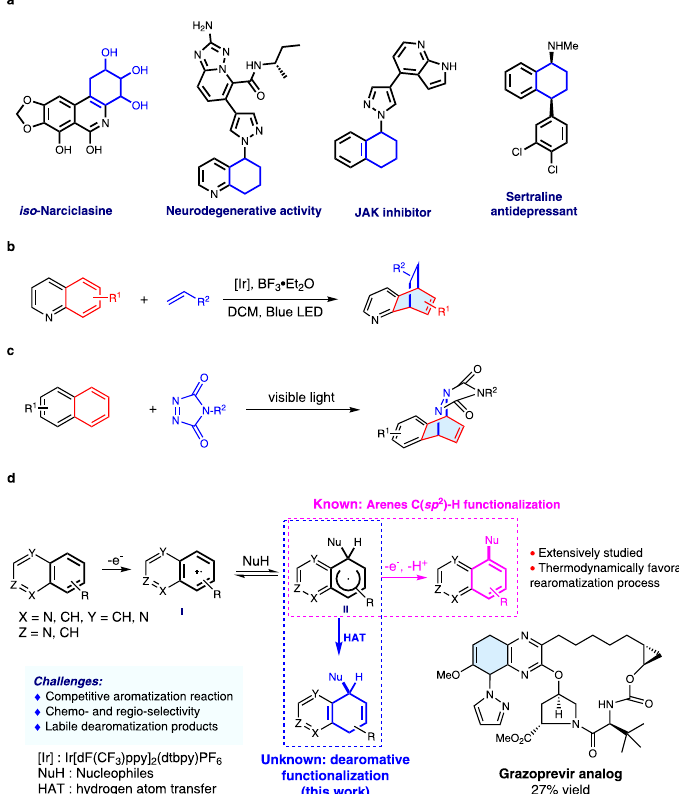
Fig. 1 | Methods for selective dearomative functionalization of fused arenes. a Examples of partially dearomatic natural products and bioactive compounds. b Selective dearomatization of quinolines. c Selective dearomatization